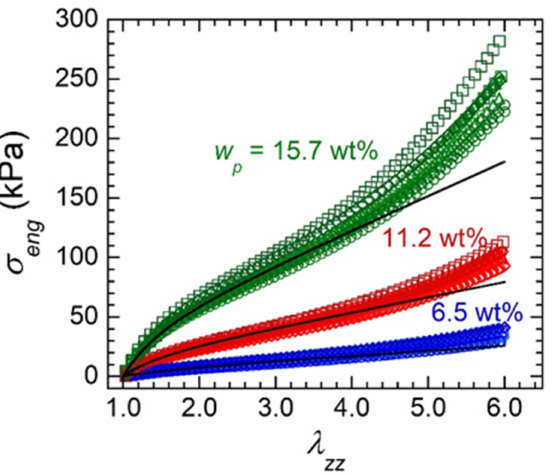
Figure 2. Representative stress–stretch profiles for gels containing various oils (circles = squalane, squares = HB 200, diamonds = HB 380, triangles = HB 550, crosses = HB 1000) at different SEBS concentrations (labeled) with either 0.5 wt% OA (light symbols) or 1.0 wt% AOT (dark symbols). Lines indicate a representative STN model fit for each group of fixed SEBS concentration